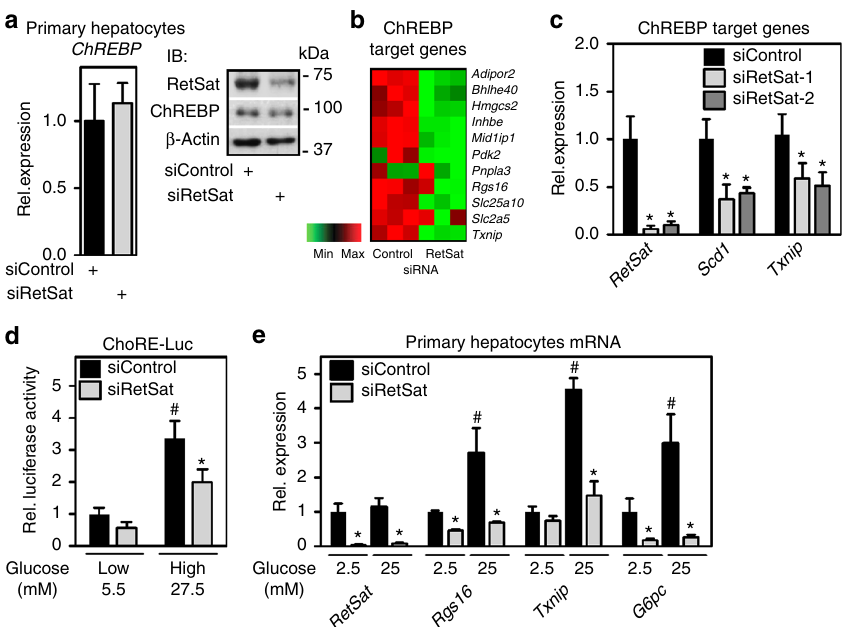
Fig. 5 RetSat controls ChREBP activity and glucose sensing in primary hepatocytes. Primary mouse hepatocytes were treated with Control or RetSat siRNA for 48 h, ( a , left ) ChREBP mRNA expression determined by qPCR, and RetSat and ChREBP protein levels determined by immunoblotting ( a , right ). left , Data are shown as mean ± 11s.d., n = 3 independent transfections of hepatocyte cultures from the same mouse. Two independent experiments yielded similar results. b Hepatocytes were treated as described in a and mRNA expression of a selection of known ChREBP target genes visualized in a heatmap. c Primary hepatocytes were depleted of RetSat using two siRNA ’ s targeting different sites of the RetSat transcript for 48 h, and expression of the indicated genes analyzed by qPCR. Data are shown as mean ± s.d., n = 6 independent transfections of hepatocyte cultures from two different mice; * P < 0.05 between siControl und siRetSat by one-way ANOVA with Bonferroni post test. An independent experiment yielded similar results. d Hepatocytes treated with Control or RetSat siRNA were transfected with a ChoRE-Luc reporter, exposed to low and high glucose concentrations as indicated, and analyzed for luciferase activity. e Hepatocytes treated with Control or RetSat siRNA were exposed to low and high glucose concentrations as indicated, and mRNA expression determined by qPCR. In d , e , data are shown as mean ± s.d., n = 6 independent transfections of hepatocyte cultures from two mice; two-way ANOVA with Bonferroni post test revealed signi fi cances between low and high glucose concentrations ( # P < 0.05) and between siControl and siRetSat (* P < 0.05). An independent experiment yielded similar insulin-resistant mice were obtained feeding 6-week-old mice HS/HFD for at least 8 weeks. For fasting experiments, cages were replaced and food withheld for 24 h. Re-feeding experiments were carried out by providing chow diet for 4 h after the 24h fasting period. For comparing hepatic RetSat expression in lean or diet- induced obese mice, a previously described cohort was used 5 .